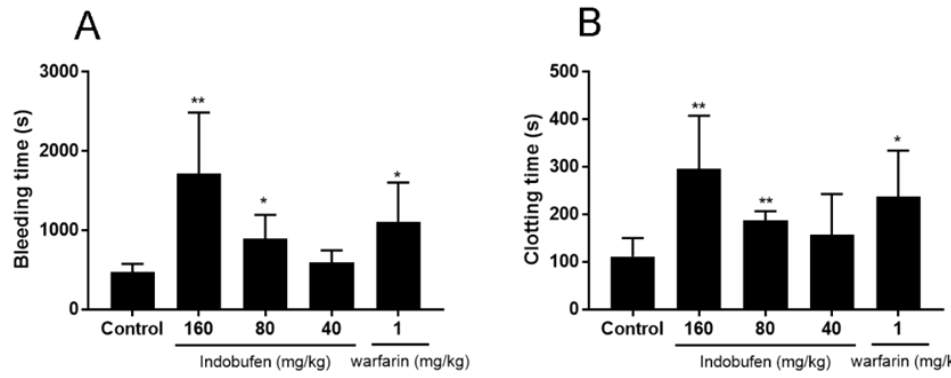
Figure 3. The effects of indobufen on bleeding time ( A ) and clotting time ( B ) in mice. * p < 0.05, ** p < 0.01 versus the control group; (mean ± S.D., n = 10).